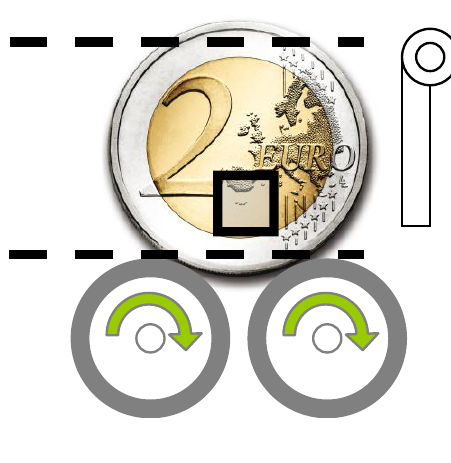
Figure 7. Schematic view of the proposed two-Euro counterfeit coin detector. The square is a representation of the area of the image acquired by one optical